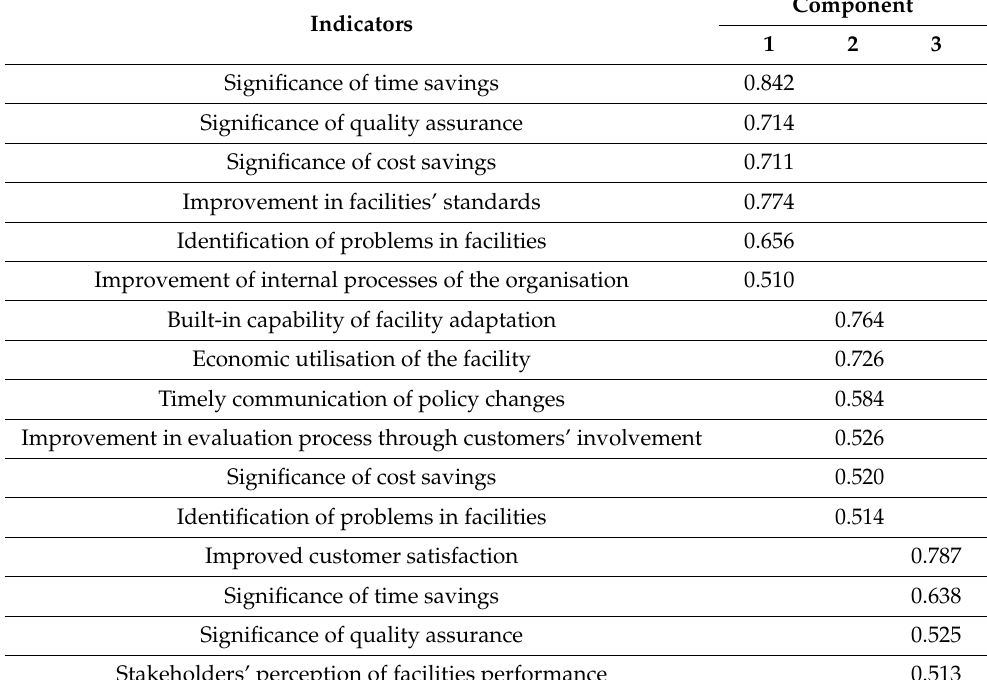
Table 4. Rotated Component